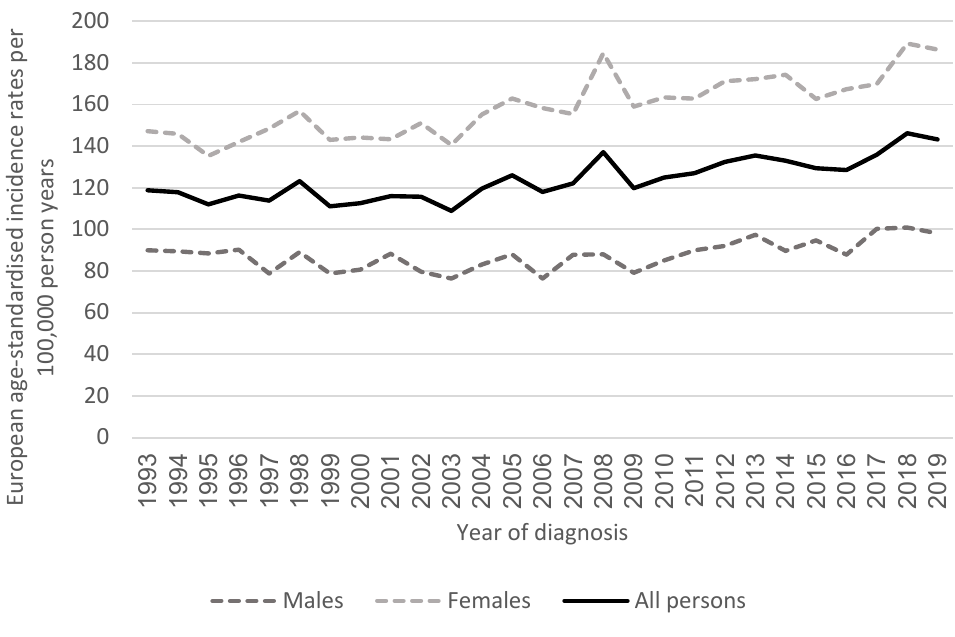
Figure 1. Age-standardised incidence rates of cancer (excluding non-melanoma skin cancer) by year of diagnosis in Northern Ireland in adults aged 18–49 years.